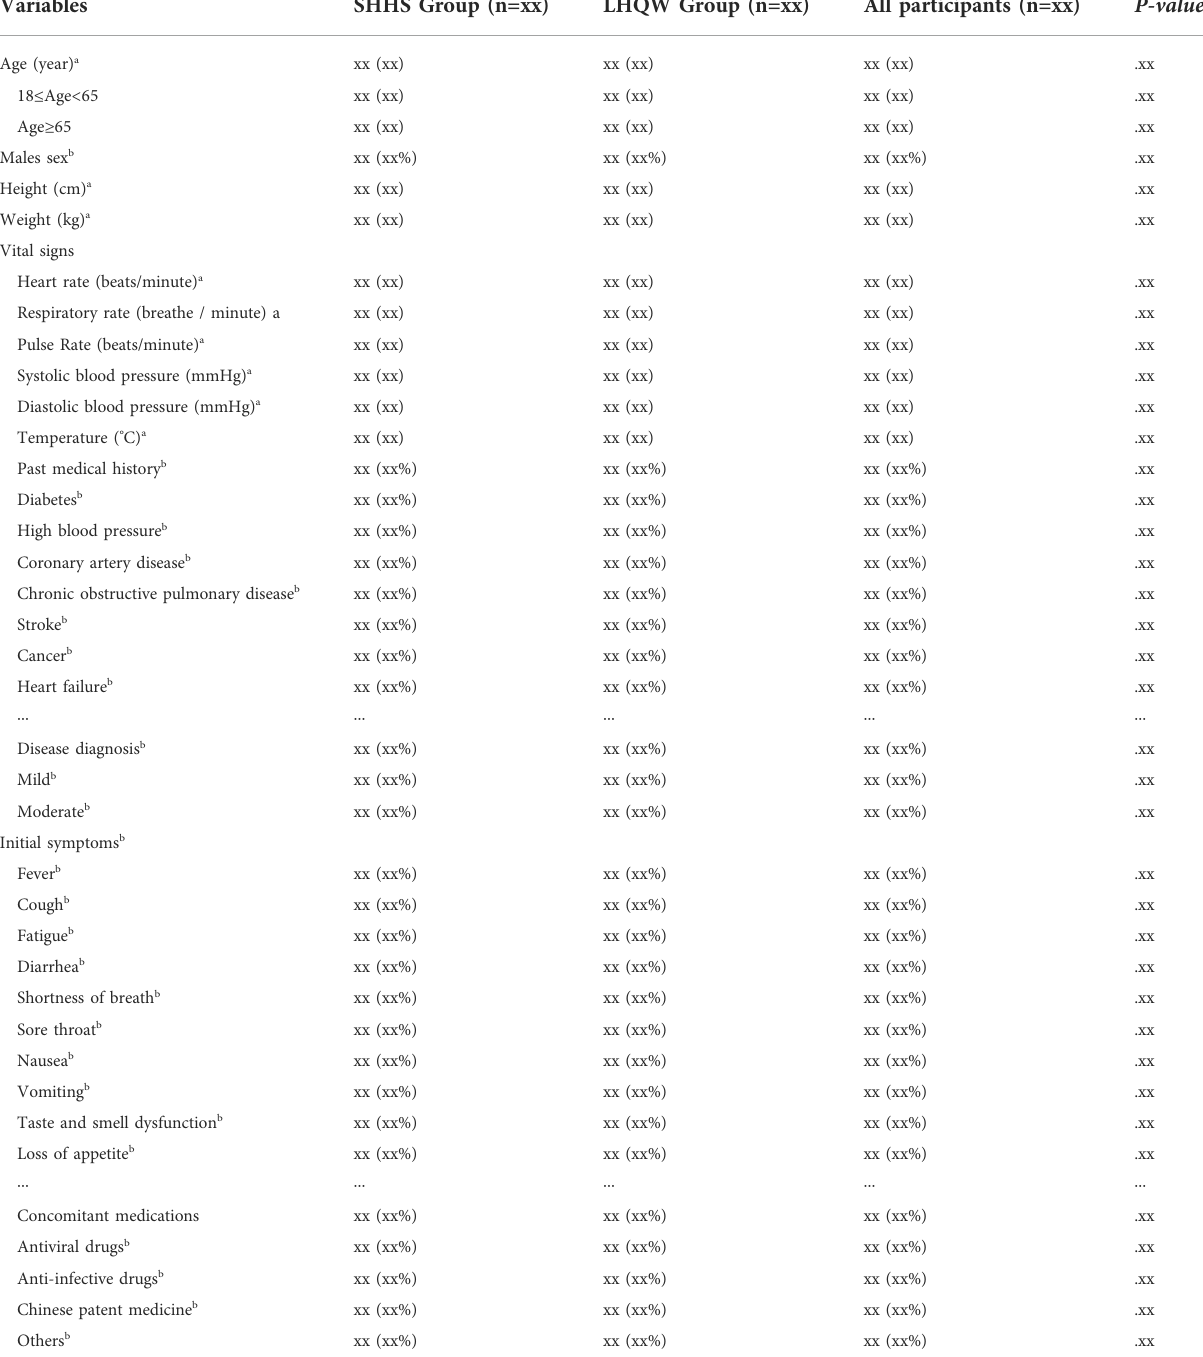
TABLE 2 Baseline demographic and clinical